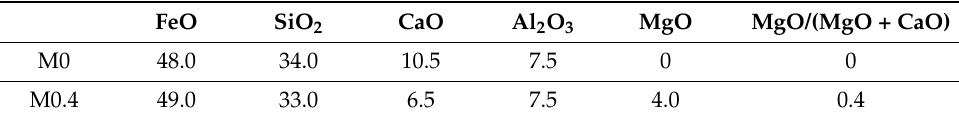
Table 1. Chemical composition of slags (wt%), obtained by XRF.